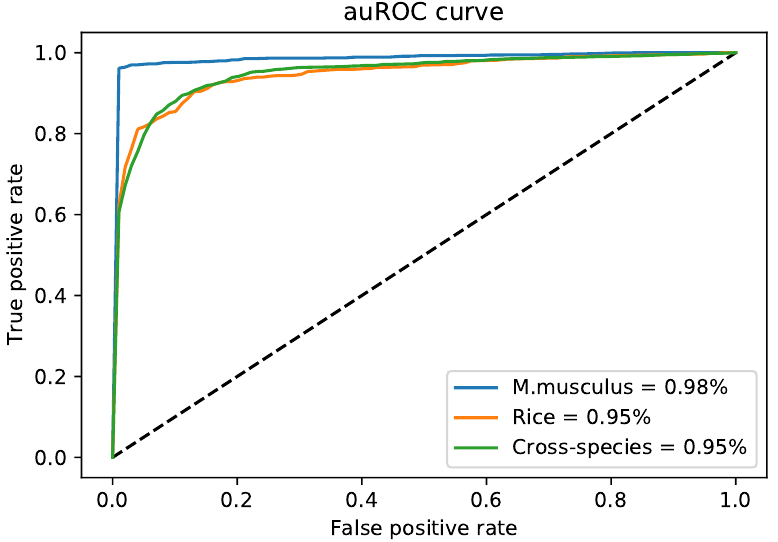
Figure 3. AuROC for M. musculus , Rice, and “Combined-species” genomes.